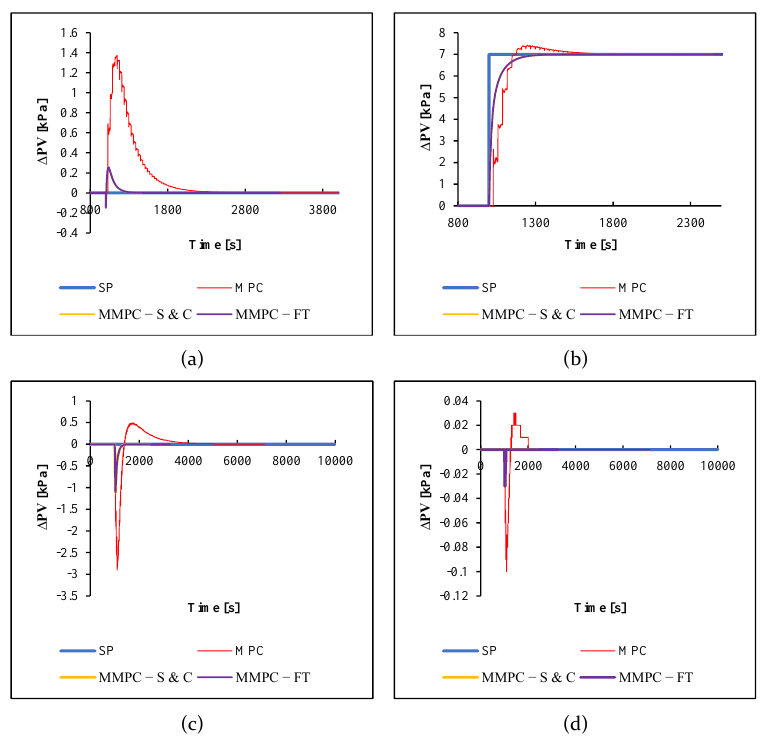
Figure 8. Comparison of controller performance with SP changes on compressor unit 2 (MIMO Model 2) on: ( a ) compressor unit 1; ( b ) compressor unit 2; ( c ) compressor unit 3; and ( d ) compressor unit 4.